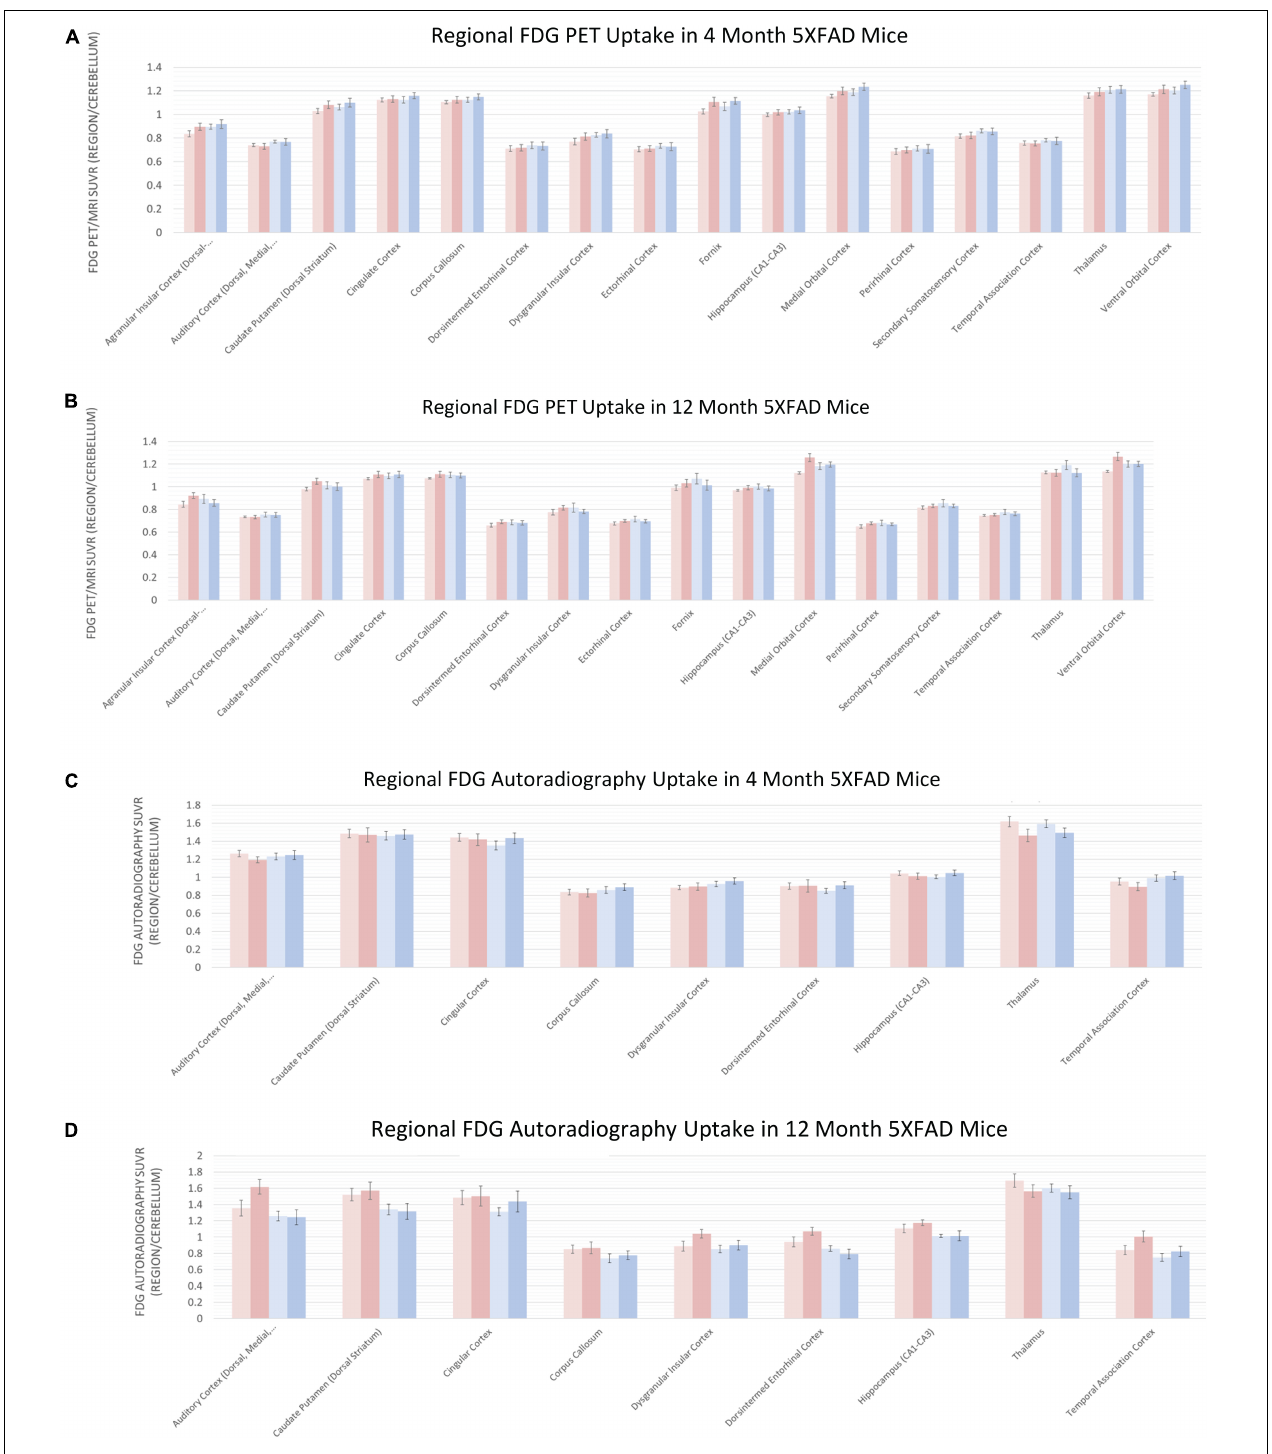
FIGURE 7 | Regional increases in glycolysis via [18F]-FDG PET/MRI and confirmed by Autoradiography. Positron emission tomography (PET) of radiopharmaceutical [18F]-FDG was used to measure tissue glucose uptake. PET data presented as brain regions normalized to the cerebellum are quantified in panels (A,B) at 4 and 12 months, respectively. Post-mortem autoradiography of coronal brain tissue is represented in panels (C,D) .